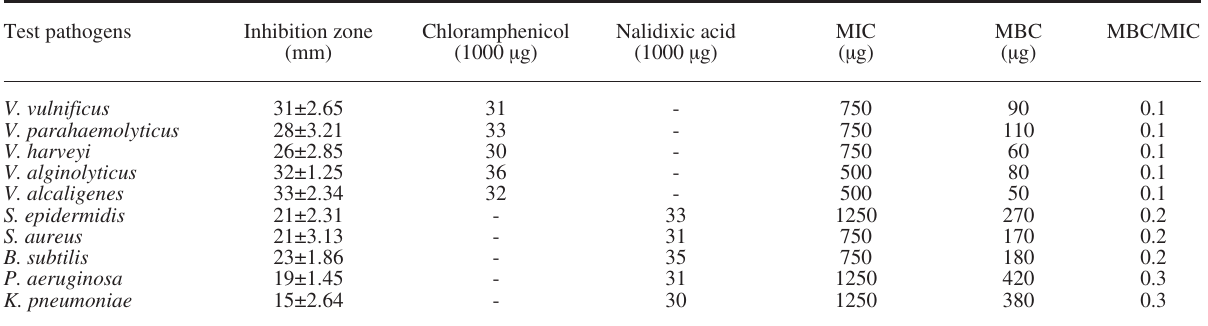
Table 4. – Antimicrobial activities of methanolic extracts (1000 µg /ml) of the Falkenbergia- phase of A. taxiformis. Test